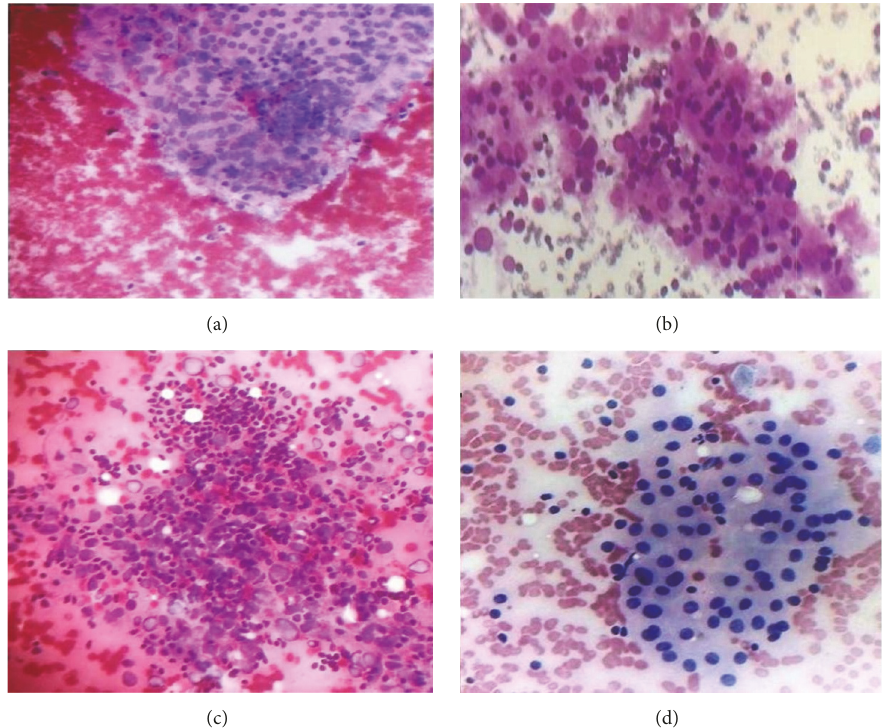
Figure 1: Hashimoto’s thyroiditis: (a) Group 1 smears showing follicular cell clusters infiltrated by few lymphocytes (Leishman’s stain × 100); (b) Group 2 smears showing follicular cell clusters infiltrated by moderate amount of lymphocytes (Leishman’s stain × 400); (c) Hurthle cells and increased background lymphocytes (Leishman’s stain × 400); (d) dense lymphocytes in follicular cells clusters (Haematoxylin & Eosin × 100).